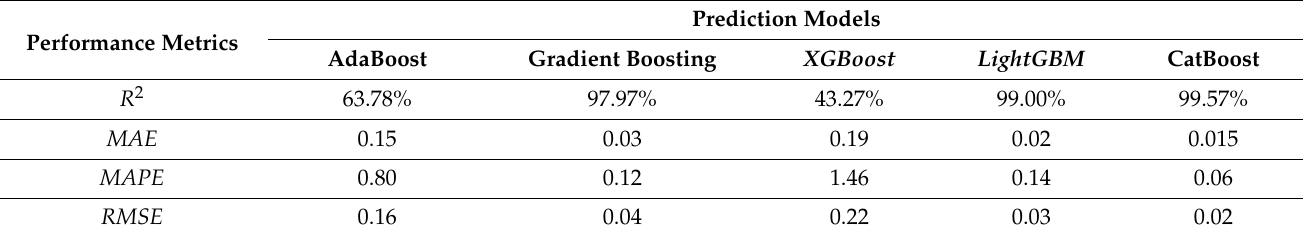
Table 3. Performance comparison of the ML models.